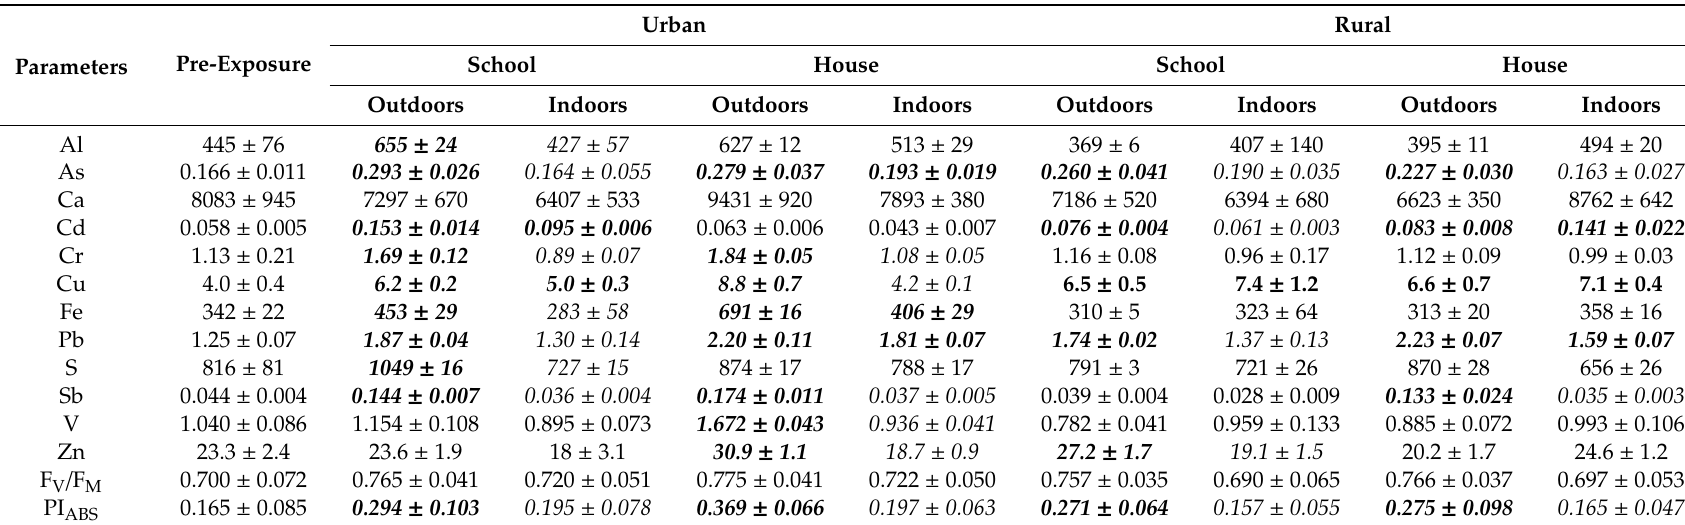
Table 1. Element concentrations ( µ g g − 1 , N = 3) and photosynthetic parameters (potential quantum yield of primary photochemistry—F V / F M and performance index—PI ABS , N = 30) in the lichen Evernia prunastri before and after indoor or outdoor exposures (average ± standard deviation). As a first step we checked whether a significant accumulation (or variation of photosynthetic parameters) occurred, and the values in bold are significantly higher than the control samples; in such cases, we checked whether samples in the same locality di ff er according to their indoor / outdoor exposure (pairs in italics) (Mann–Whitney U test, p <